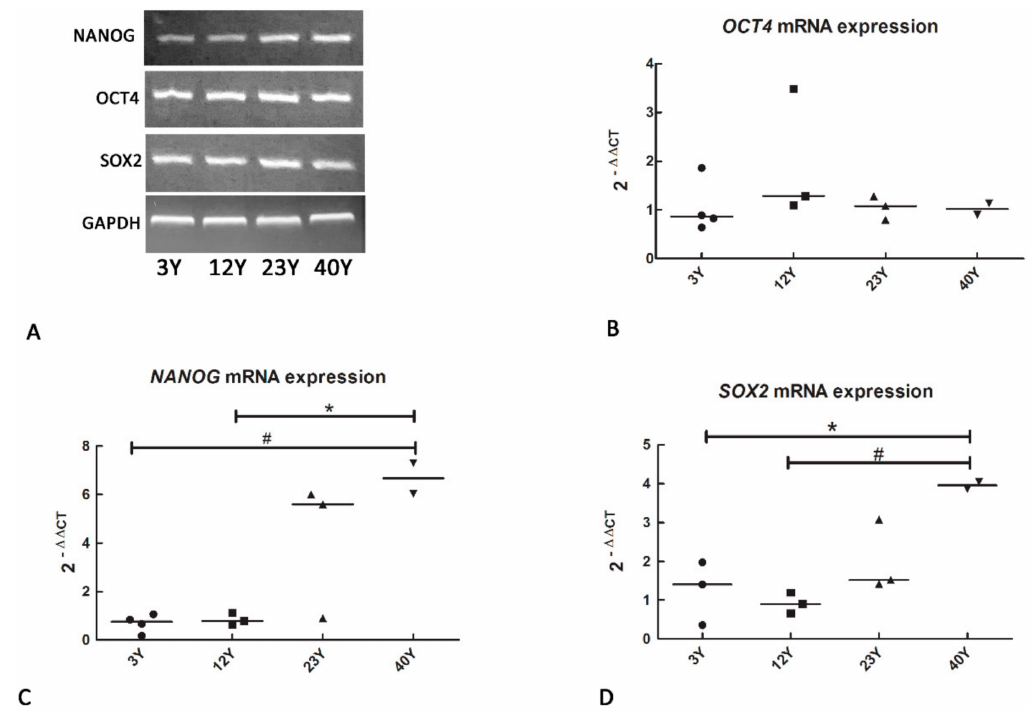
Figure 2. ( A ) RT-PCR analysis showing a positive expression of NANOG , OCT4 , and SOX2 self-renewal markers in SfMSCs cultured from equine donors of different ages: 3Y (3 years old), 12Y (12 years old), 23Y (23 years old), and 40Y (40 years old). Representative images of three independent experiments; ( B ) real-time PCR data showing the quantitative expression of NANOG mRNA in each single donor and the mean level inside each group (black line). No statistical differences were observed between groups. ( C ) Real-time PCR data showing the quantitative expression of NANOG mRNA in each single donor and the mean level inside each group (black line). * represents a significant difference between the 12Y and 40Y group; p < 0.05. # represents a significant difference between the 3Y and 40Y group; p < 0.05. ( D ) Real-time PCR data showing the quantitative expression of SOX2 mRNA in each single donor and the mean level inside each group (black line). * represents a significant difference between the 3Y and 40Y group; p < 0.05. # represents a significant difference between the 12Y and 40Y group; p <